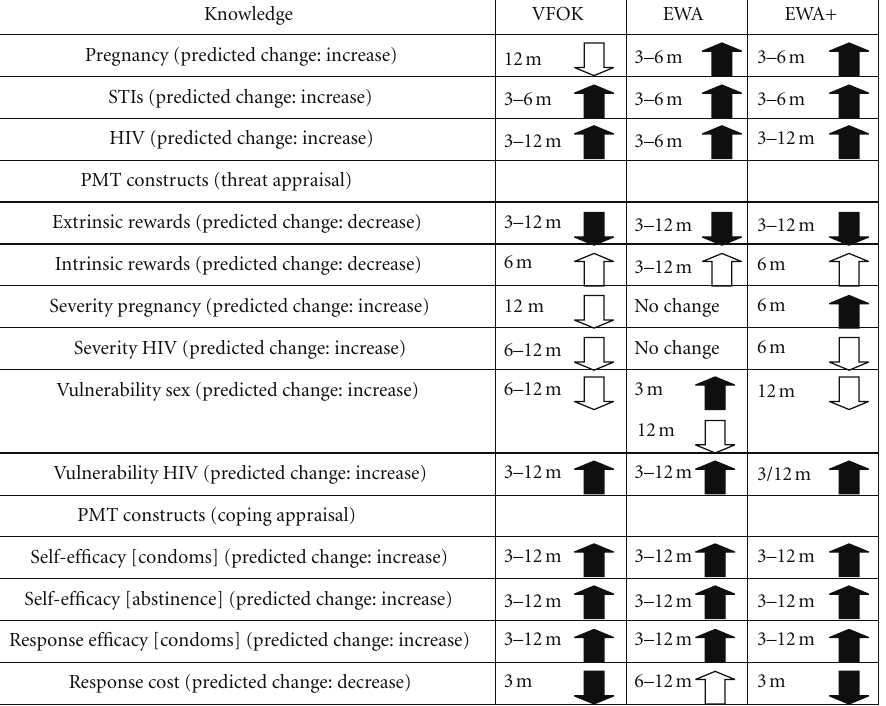
Figure 2: Statistically significant change ( P < 0 . 05) for knowledge and PMT constructs by intervention (3, 6, and 12 months after inter-